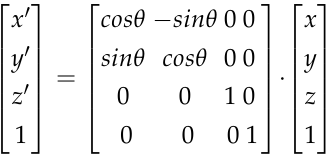
Figure 4. Examples of multiple detections of the same object across the seam.